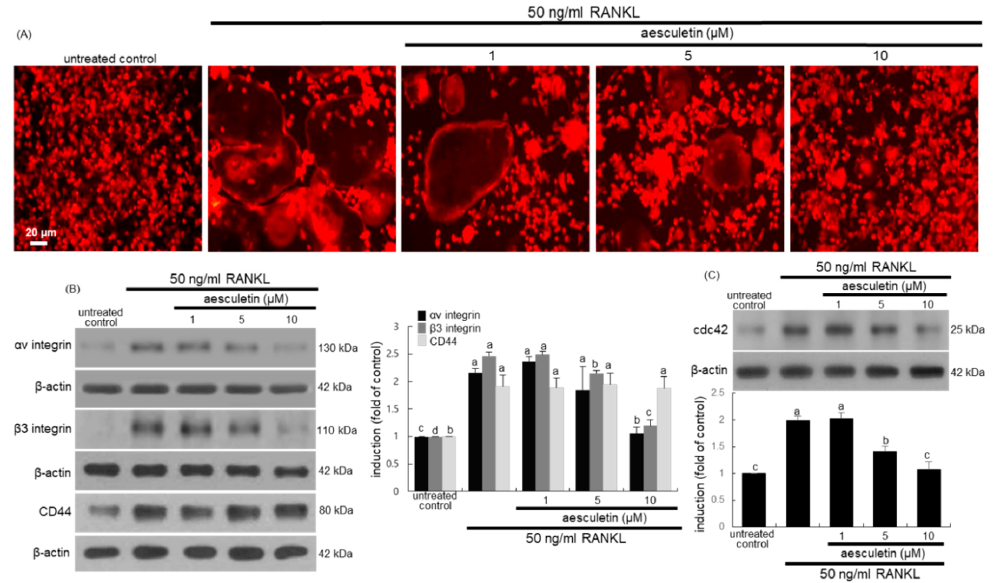
Figure 4. Blockade of receptor activator of nuclear factor- κ B ligand (RANKL)-induced actin ring formation ( A ) and induction of integrins, cluster of differentiation 44 (CD44) and Cdc42 ( B , C ) in mature osteoclasts. Raw 264.7 cells were cultured for 5 days with 50 ng/mL RANKL in the absence or presence of 1–10 μ M aesculetin. Differentiated cells were fixed in 4% formaldehyde for 10 min, and fluorescent rhodamine phalloidin was added to fixed cells and hence incubated for 20 min at 4 °C ( A ). Fluorescent images were taken with an Axiomager Optical fluorescence microscope. Original magnification of microscopic images ( n = 3). Scale bar = 20 μ m. After whole-cell extracts were subject to sodium dodecyl sulphate-polyacrylamide gel electrophoresis (SDS-PAGE) and Western blot analysis with a primary antibody against α v integrin, β 3 integrin, CD44, and Cdc42 ( B , C ). Representative blot data were obtained from three independent experiments, and β -actin protein was used as an internal control. The bar graphs (mean ± SEM) represent quantitative results obtained from a densitometer. Respective values in different-colored bar graphs not sharing a small letter indicate a significant difference at p <